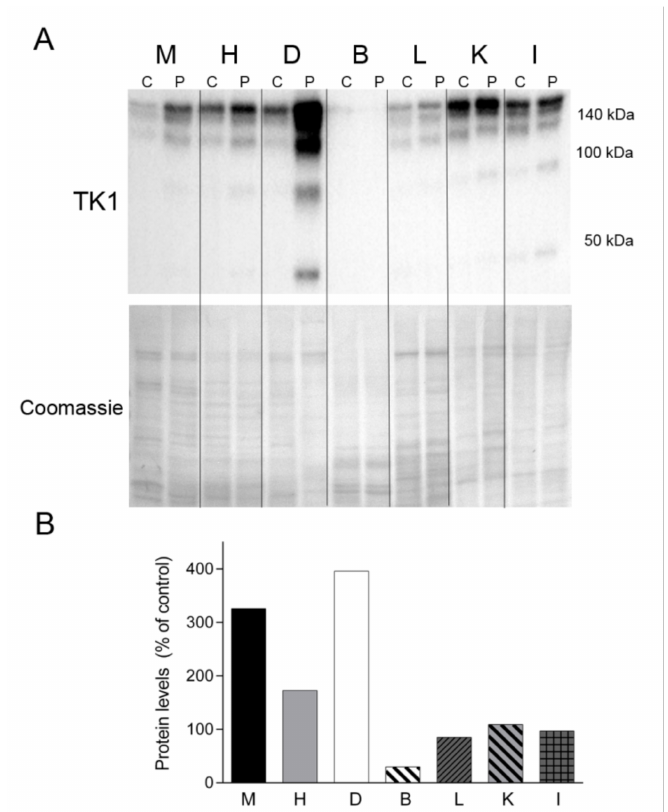
Figure 8. TK1 levels. ( A ) Western blotting of TK1 in tissue homogenate samples treated with dithiothreitol from a control (C) (n = 1) and the patient (P). Coomassie straining of the membranes is shown as total protein loading control. ( B ) Densitometry analysis: protein levels were normalized to total protein loading according to Coomassie blue staining. Data are expressed as percentage of control tissue Abbreviations: M, skeletal muscle; H, heart; D, diaphragm; B, brain; L, liver; K, kidney; I, small intestine. TK1, thymidine kinase